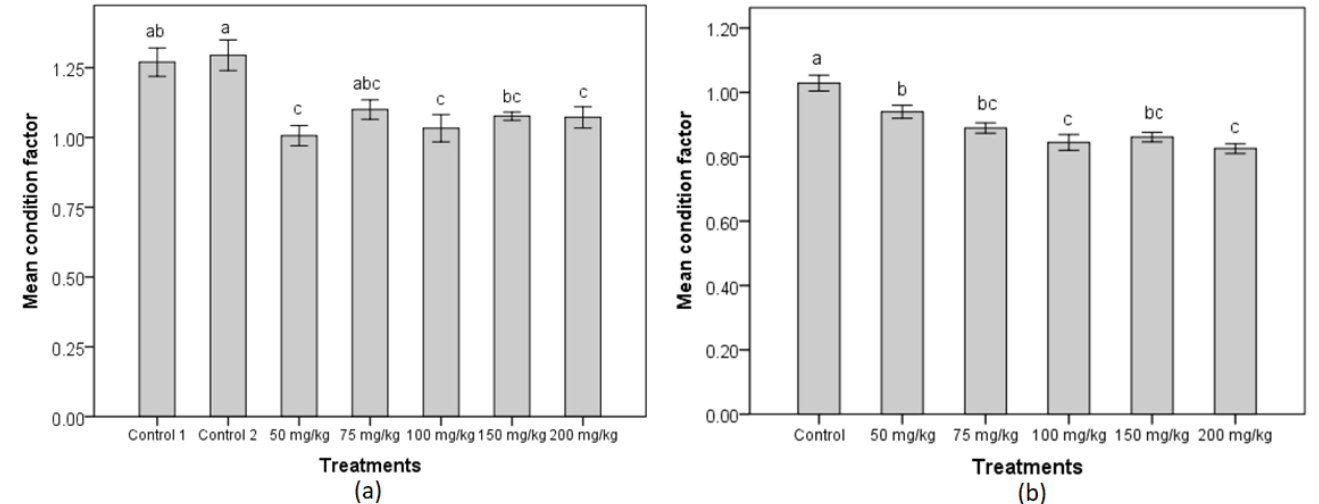
Figure 2. Condition factors of RG females and MG females post 50-day MT treatment period. ( a ) Mean final condition factors (±SE, n = 5) of RG females and ( b ) mean final condition (±SE, n = 12) of MG females. Means with a different letter are significantly different from one another. Control 1/control groups received feed without any hormone, while control 2 group received feed incorporated with 70% ethanol as vehicle control.